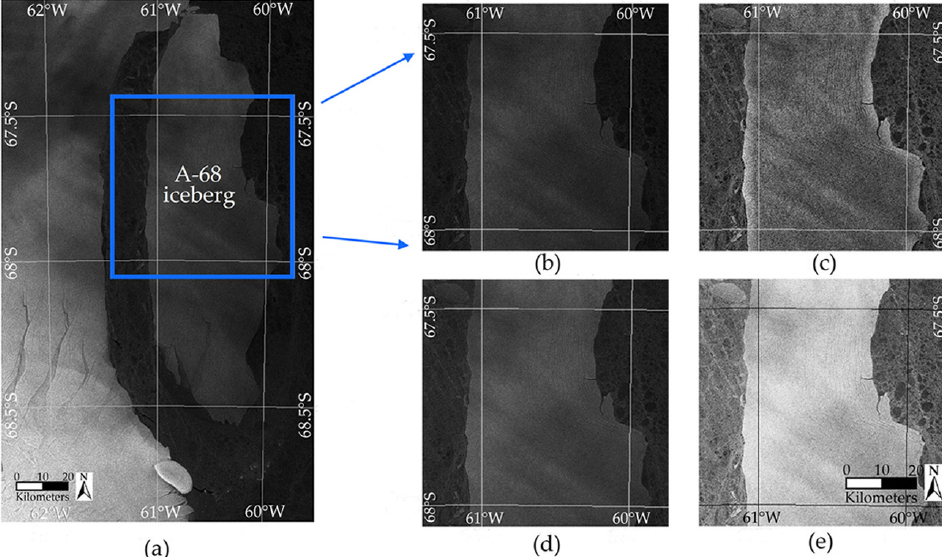
Figure 2. Comparison of contrast enhancement algorithms: ( a ): Overview of the input SAR image of 13 December 2017; ( b ): Window of the SAR input image; ( c ): Result of the CLAHE algorithm; ( d ): The exponential grey-scale transformation, and ( e ): Result of the applied fuzzy algorithm. This algorithm improves the dark and bright feature contrast. As a result, the mapping of the grey level range enhances the discrimination of the iceberg